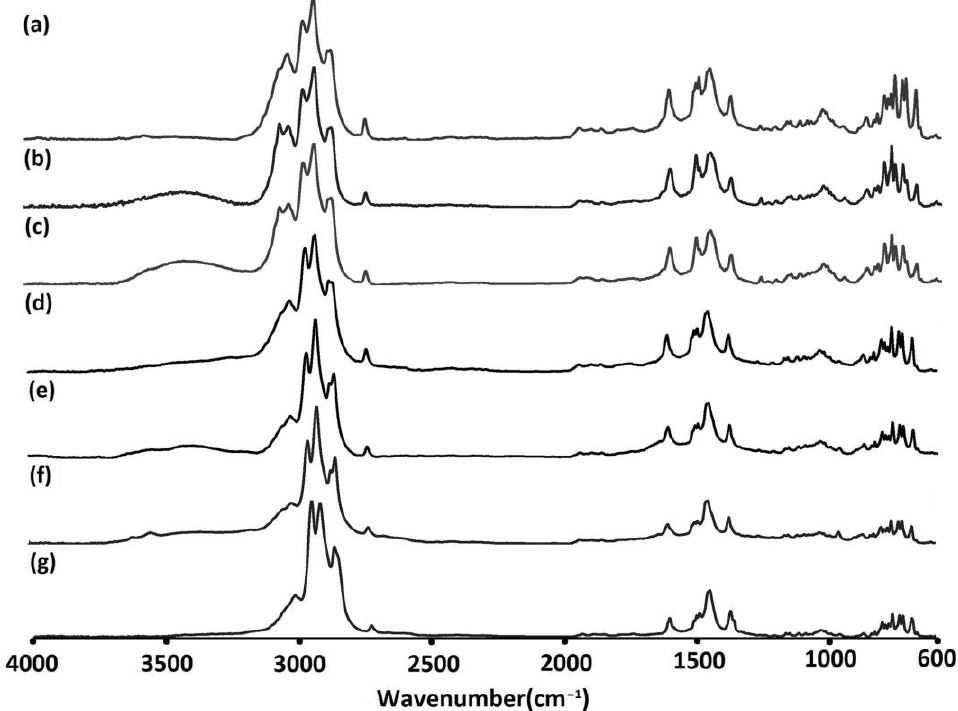
Figure 9. FTIR spectra of liquid products of catalytic pyrolysis of BMP at ( a ) 500 °C, ( b ) 550 °C, ( c ) 600 °C; CMP at ( d ) 500 °C, ( e ) 550 °C, ( f ) 600 °C; and ( g ) gasoline .